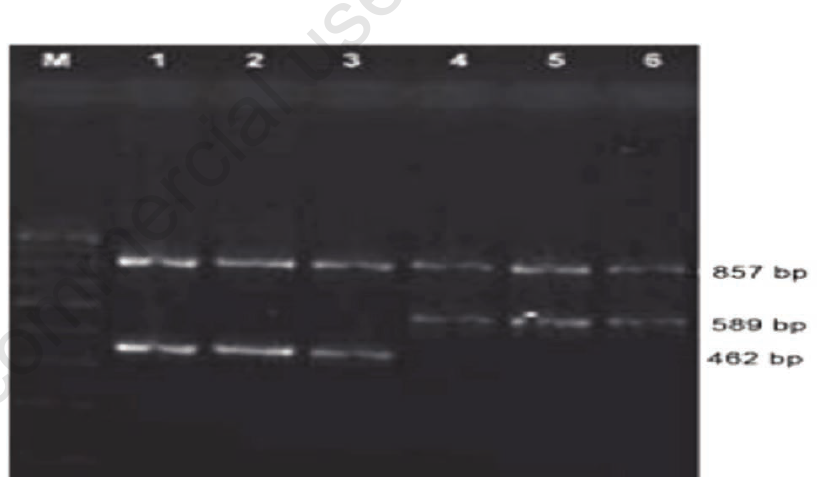
Figure 1. Multiplex PCR amplicons on 1.5% agarose gel. Lane M: 100 bp ladder; Lane: 1, 2, 3 - C. coli ; Lane: 4, 5, 6 - C.